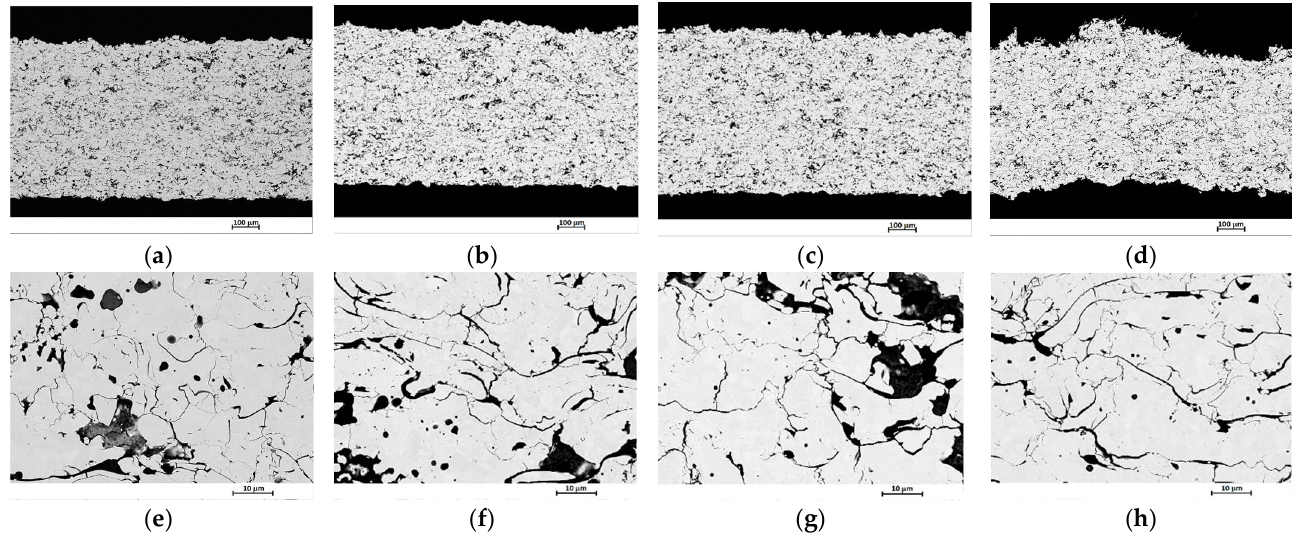
Figure 2. SEM images of the free-standing coatings with lower magnification ( a ) NaCl, ( b ) EC, ( c ) HCl, and ( d ) graphite, and higher magnification ( e ) NaCl, ( f ) EC, ( g ) HCl, and ( h ) graphite.